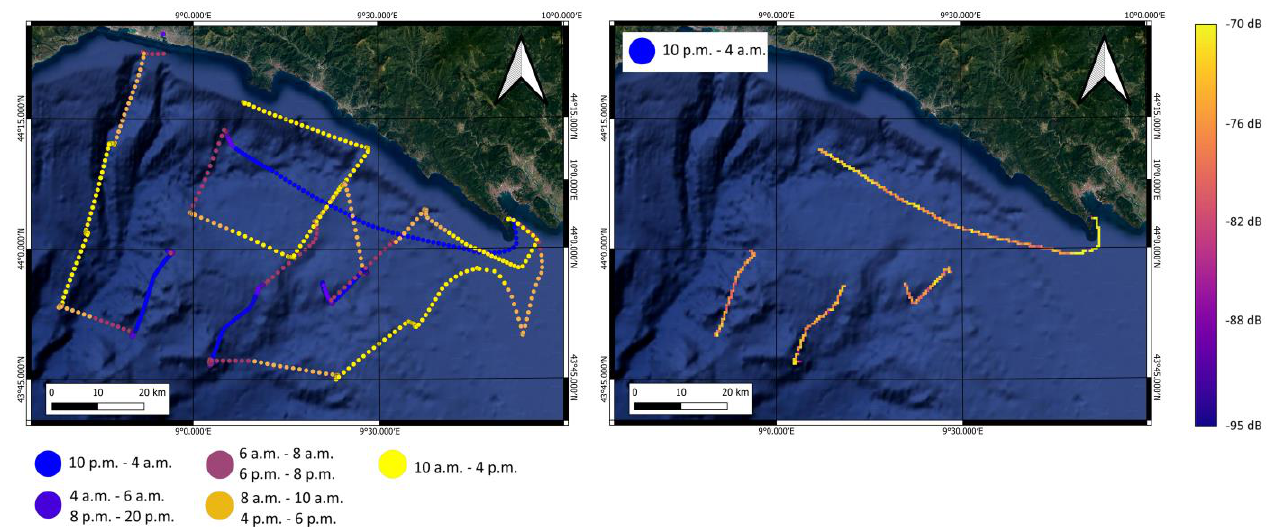
Figure 4. GIS layer of the sampling route of 2017 campaign with color coding associated to the different phases of the day. Backscatter strength values at 50 m depth for the nighttime is evidenced in the right panel.